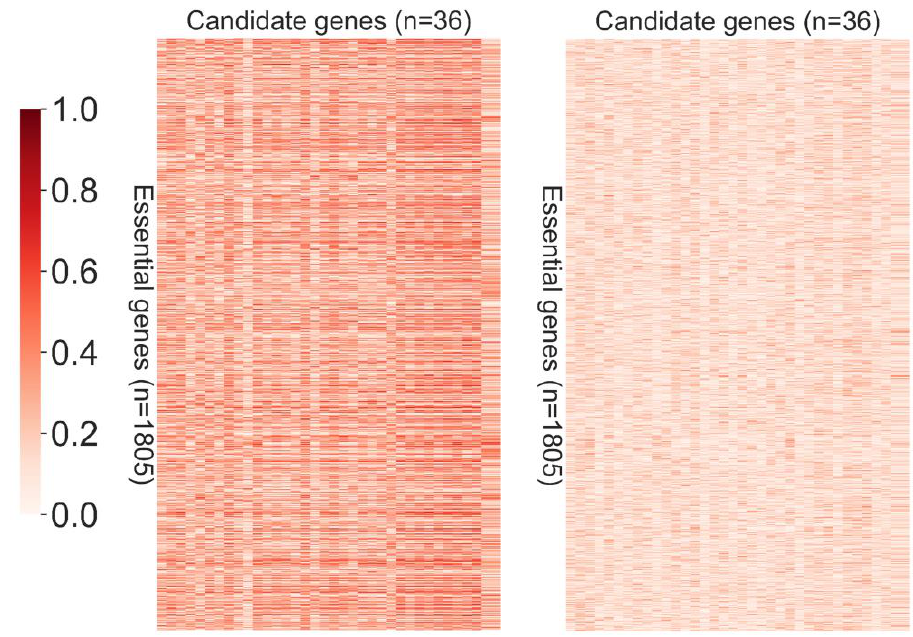
Figure 4. Correlation between the overlapping candidate genes and known essential genes. Left: HBV(+) samples, right: HBV(−) samples.